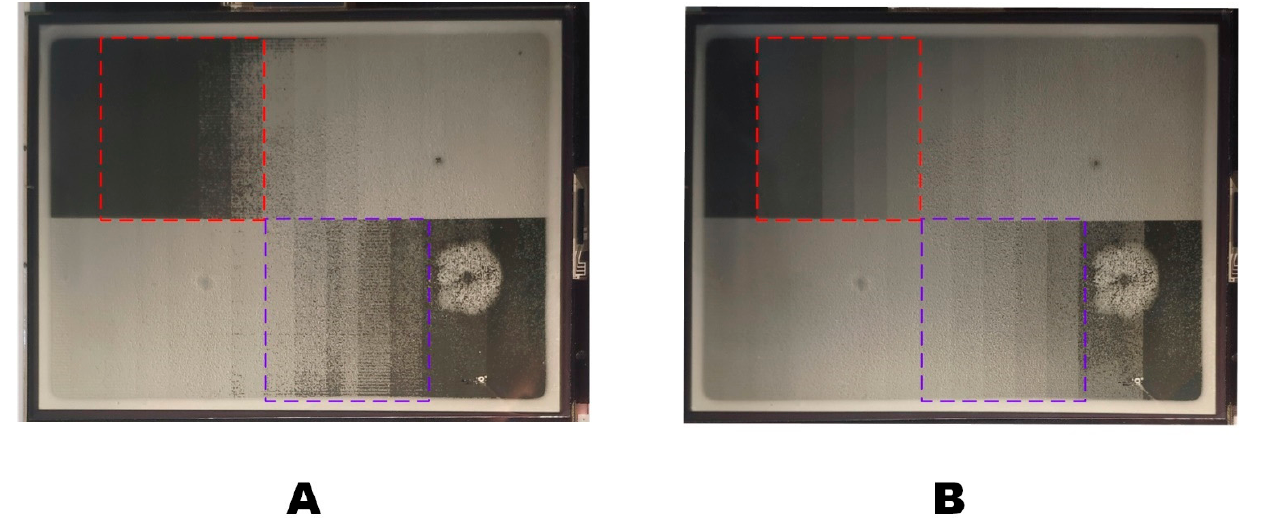
Figure 16. Each driving waveform was applied to a TFT-EWD to display gray scales, the red and purple squares show the difference of grayscale display under different waveforms. ( A ) The EWD driving by a 15 V DC driving waveform. ( B ) The EWD driving by a multi-DC driving waveform.